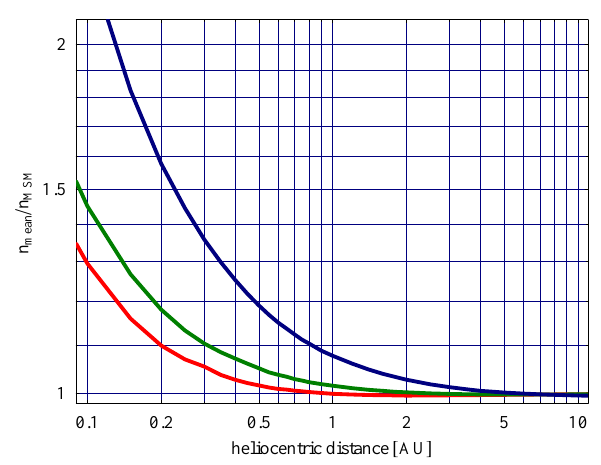
Fig. 2. Ratios of helium densities averaged over solar cycle to mean stationary densities, evaluated using the stationary model with the ionization rate equal to the mean value over the solar cycle. Red corresponds to the upwind, green to crosswind, blue to downwind